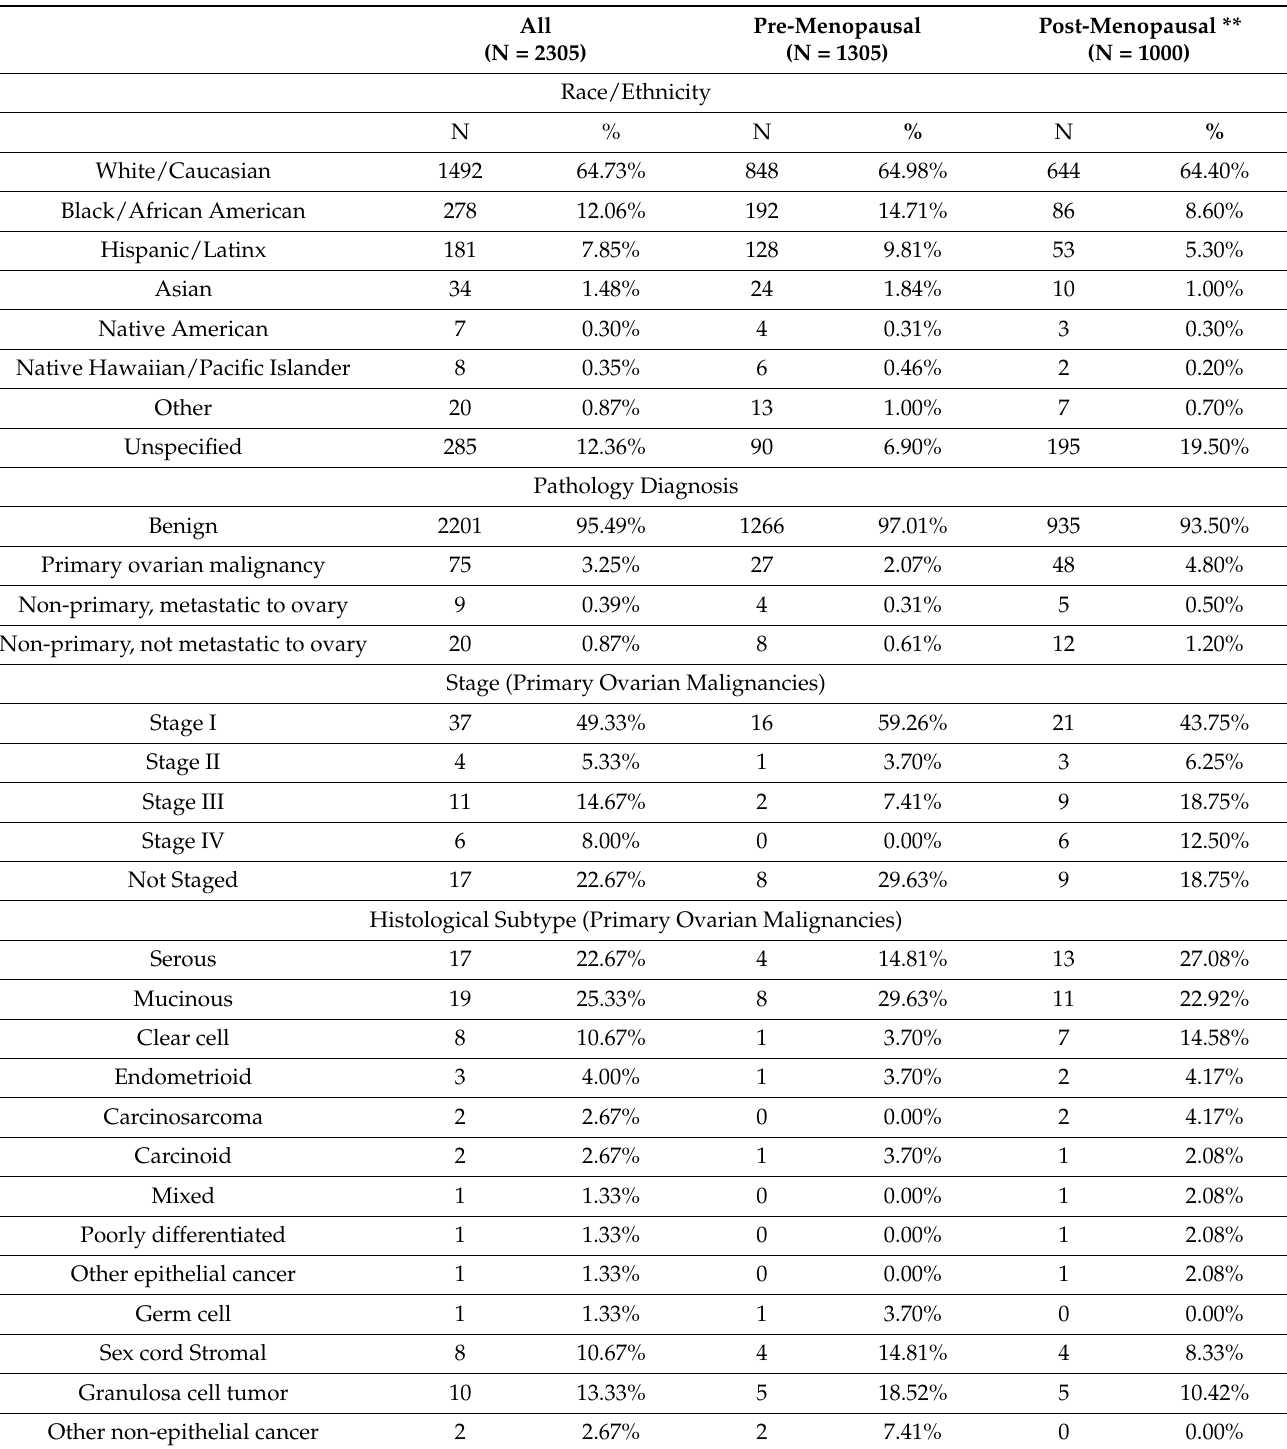
Table 1. Summary of Clinical Characteristics for the Study Population